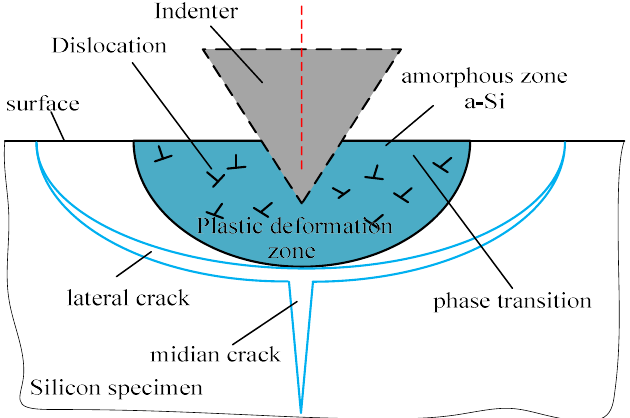
Figure 5. Schematic of damage by a sharp indenter.